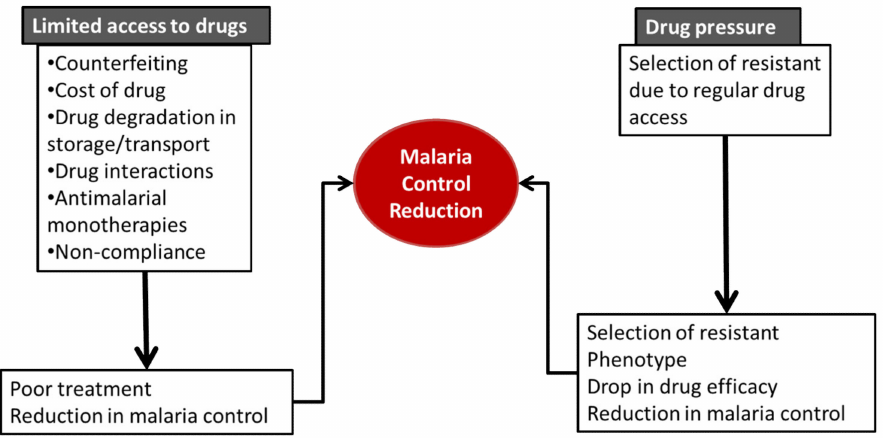
Figure 1. Impact of limited drug access and drug pressure on malaria